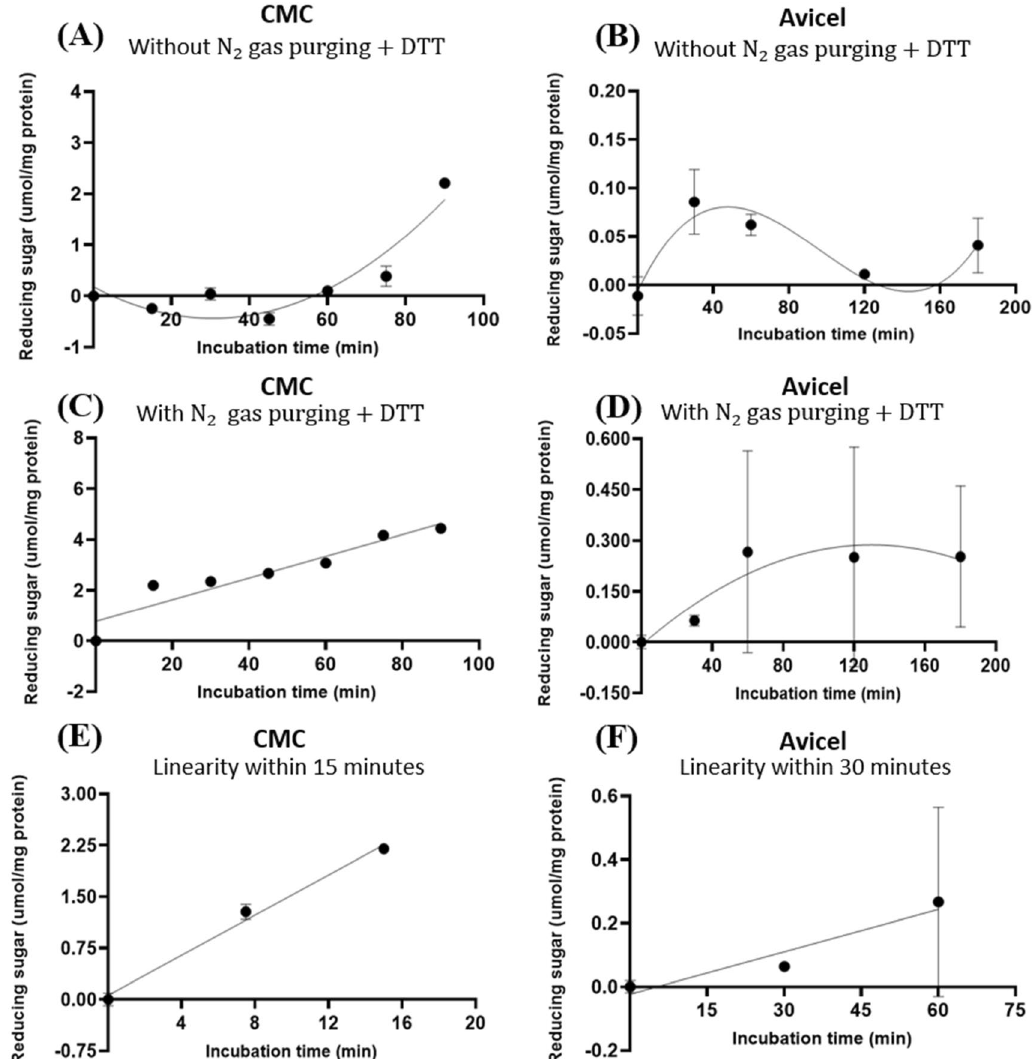
Figure 5. Experiment-1 of the time courses (y, mean ± SE, umol/mg protein) of crude GH5-p4818Cel5_2A enzyme preparation incubated with the carboxymethyl cellulose (CMC) and Avicel substrate buffers in the presence or absence of N 2 gas purging for up to 90 and 180 min, respectively, in examining the effects of auto-oxidation on GH5-p4818Cel5_2A activity. (A) Responses (y, mean ± SE , n = 4 at each time point) of the p4818Cel5_2A enzyme preparation incubated with the CMC substrate buffer without N 2 gas purging and DTT (5 mM) for up to 90 min established according to a quadratic model (model parameter estimates ± SE ) : Y = − 0.041 ( ± 0.011 ) x + 6.7 e − 4 ( ± 1.1 e − 4 ) x 2 , P = 0.342 for the intercept; P = 0.001 for the linear parameter estimate; and P < 0.0001 for the quadratic parameter estimate; R 2 = 0.777, n = 28 (B) Responses (y, mean ± SE , n = 4 at each time point) of the GH5-p4818Cel5_2A enzyme preparation incubated with the Avicel substrate buffer without N 2 gas purging and DTT (5 mM) for up to 180 min established according to a cubic model (model parameter estimates ± SE ) as: Y = 0.253 ( ± 0.059 ) x − 0.193 ( ± 0.048 ) x 2 + 0.039 ( ± 0.010 ) x 3 , P = 0.064 for the intercept; P = 0.001 for the linear parameter estimate; P = 0.002 for the quadratic parameter estimate; and P = 0.003 for the cubic parameter estimate; R 2 = 0.662, n = 20 ; (C) Responses (y, mean ± SE , n = 4 at each time point) of the GH5-p4818Cel5_2A enzyme preparation incubated with the CMC substrate buffer with N 2 gas purging and DTT (5 mM) for up to 90 min established according to a linear model (model parameter estimates ± SE ) : y = 0.856 ( ± 0.189 ) + 0.042 ( ± 0.003 ) x , P = 0.0001 for the intercept; and P < 0.0001 for the slope; r 2 = 0.874 , n = 28; (D) Responses (y, mean ± SE , n = 12 at each time point) of the GH5-p4818Cel5_2A enzyme preparation incubated with Avicel substrate buffer with N 2 gas purging and DTT (5 mM) for up to 180 min established according to a linear model (model parameter estimates ± SE ) : Y = 0.242 ( ± 0.91 ) + 0.003 ( ± 0.001 ) x , P = 0.009 for the intercept and P = 0.001 for the linear parameter estimate; r 2 = 0.145, n = 72; (E) Linear part (y, mean ± SE , n = 4 at each time point) of the (0, 7.5 and 15 min) the above -(C) the time course experiment with the p4818Cel5_2A enzyme preparation incubated with the CMC substrate buffer at 37 °C and pH 7.4 with N 2 gas purging and DTT (5 mM) established as (model parameter estimates ± SE ) : y = 0.148 ( ± 0.010 ) x , P = 0.714 for the intercept; and P < 0.0001 for the slope ; r 2 = 0.965, n = 12 ; and (F) Linear part (y, mean ± SE , n = 12 at each time point) of the (0, 15 and 30 min) the above -(D) the time course experiment with the GH5-p4818Cel5_2A enzyme preparation incubated with the Avicel buffer at 37 °C and pH 7.4 with N 2 gas purging and DTT (5 mM) established as (model parameter estimates ± SE ) : y = 0.009 ( ± 0.002 ) x , P = 0.631 for the intercept; and P = 0.0002 for the slope; r 2 = 0.315, n = 36